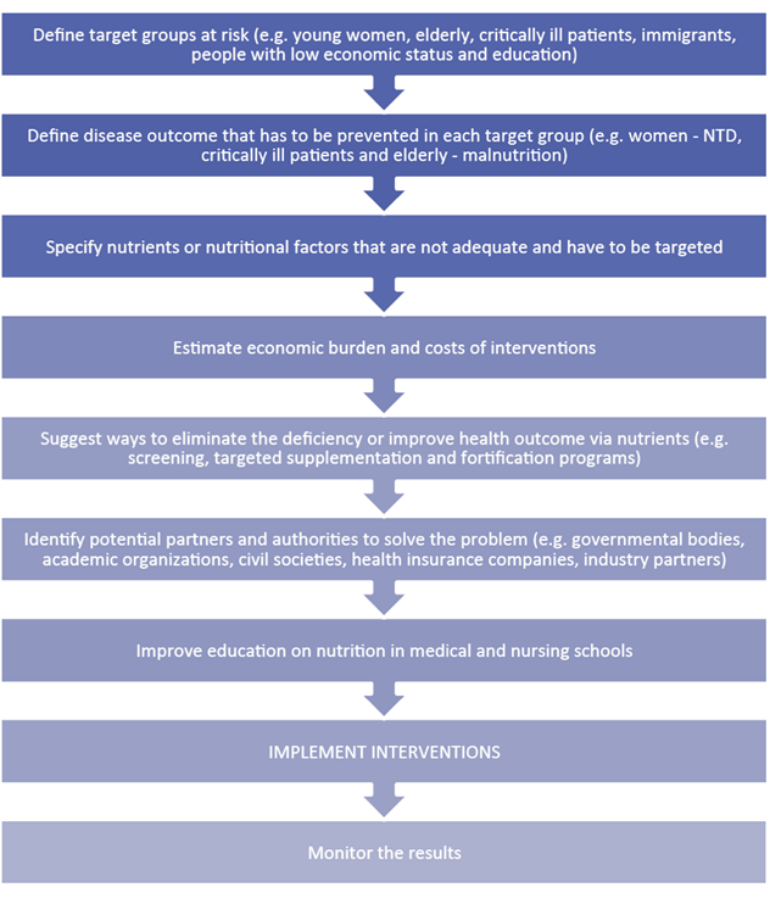
Figure 3. Suggested strategic steps to reduce the burden of hidden hunger in developed